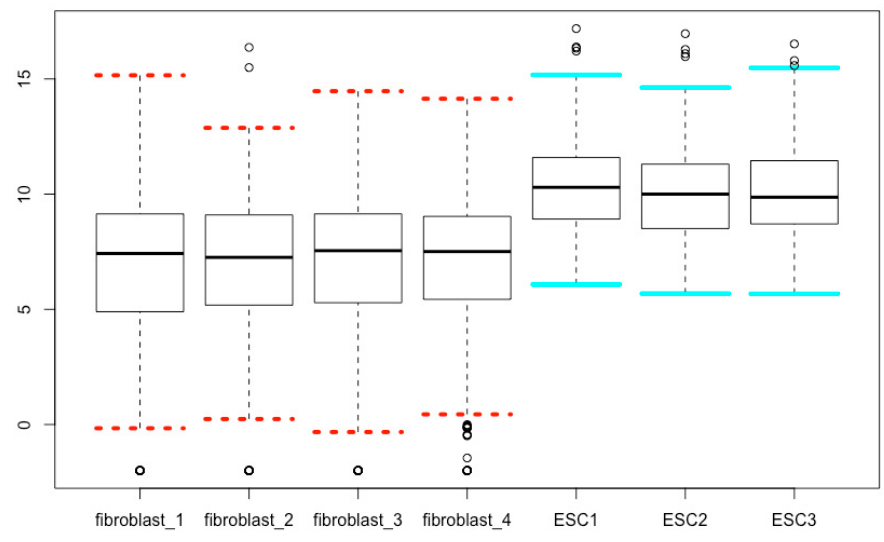
Figure 16. Define the line style, line thickness, line color, and line length of the staple part of boxplots.